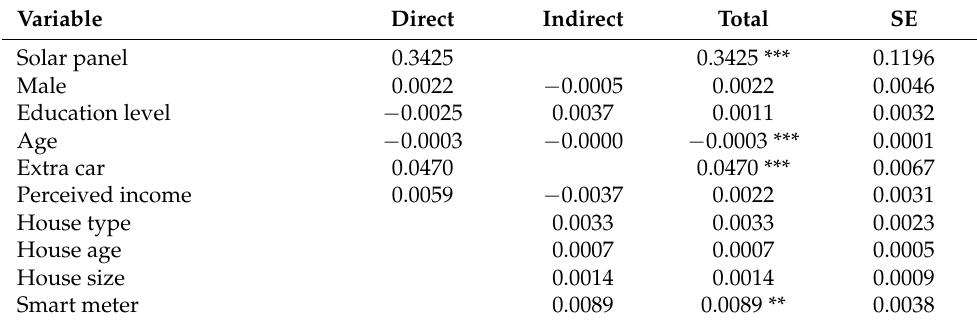
Table 4. Marginal effects on the probability that a BEV is